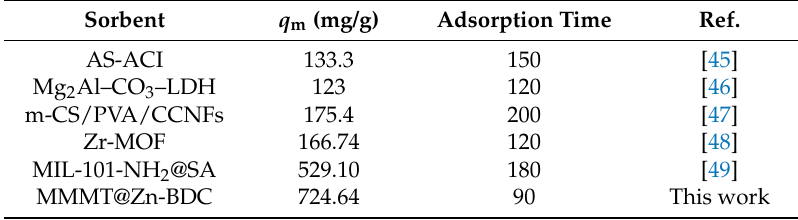
Table 6. Comparison of the adsorption capacity of MMMT@Zn-BDC for Pb(II) with that of other composite materials.